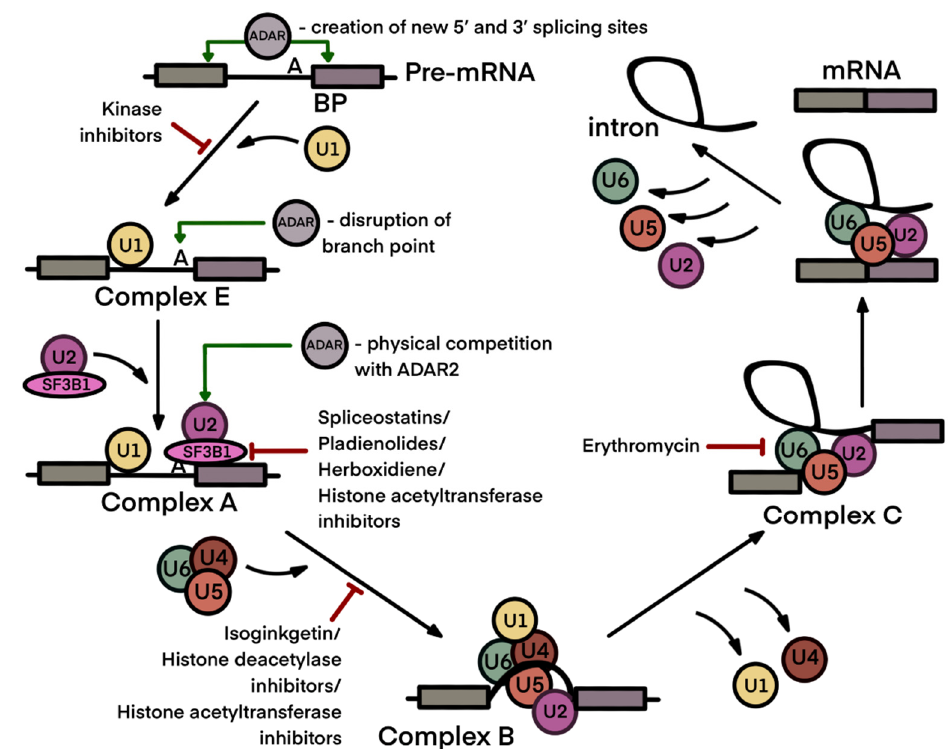
Figure 3. Pre-mRNA splicing process with application points of ADAR enzymes and spliceosome inhibitors. Application points of ADARs and spliceosome inhibitors are designated by green and red arrows, respectively. The pre-mRNA splicing process includes two steps: the recognition of the splicing sites at intron–exon junctions and a branch point sequence (BP), and intron removal and exon end joining. The splice sites are recognized by the U1 small nuclear ribonucleoprotein (snRNP) together with splicing proteins SF1 and U2AF, forming the E complex (early spliceosome). Then, SF1 is replaced by the U2 snRNP to form the A complex (pre-spliceosome). SF3B1 in the U2 snRNP stabilizes the duplex between U2 snRNA and the BP, which is a signal for the recruitment of U4/U6. U5 tri-snRNP enables the formation of the B complex. Then, the spliceosome undergoes a series of intermediate states (Bact, B*, C, C*, P and the intron lariat spliceosome). Both mammalian enzymatically active ADAR isoforms may modify 5 ′ and 3 ′ splicing sites and a branch point sequence. ADAR2 may physically interfere with the U2 spliceosome complex (see Section 3). Splicing inhibitors predominantly affect spliceosomal assembly at the early stages (see Section 4). Figure composed based on [108], with